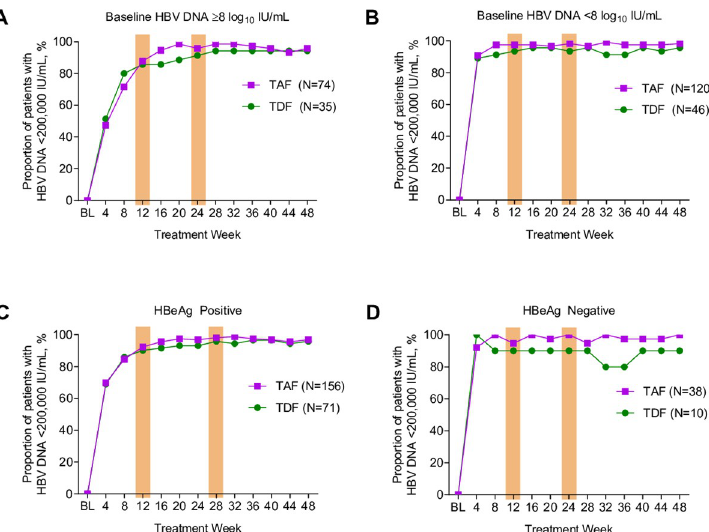
Fig 2. Rates of viral decline to < 200,000 IU/mL by select baseline characteristics. Baseline Viral Load (A) � 8 log 10 IU/mL and (B) < 8 log 10 IU/mL, (C) HBeAg-positive and (D) HBeAg-negative patients. TAF, tenofovir alafenamide; TDF, tenofovir disoproxil fumarate.